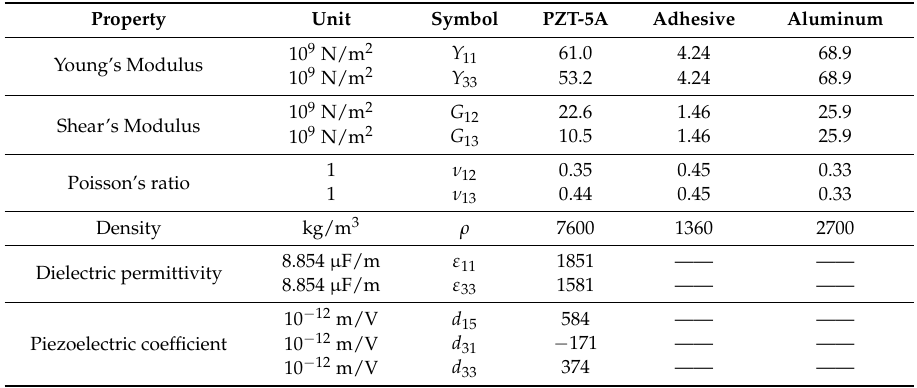
Table 2. Material properties of the shear-mode [25,26], Hysol EA9394 [28], and Aluminum 6061.